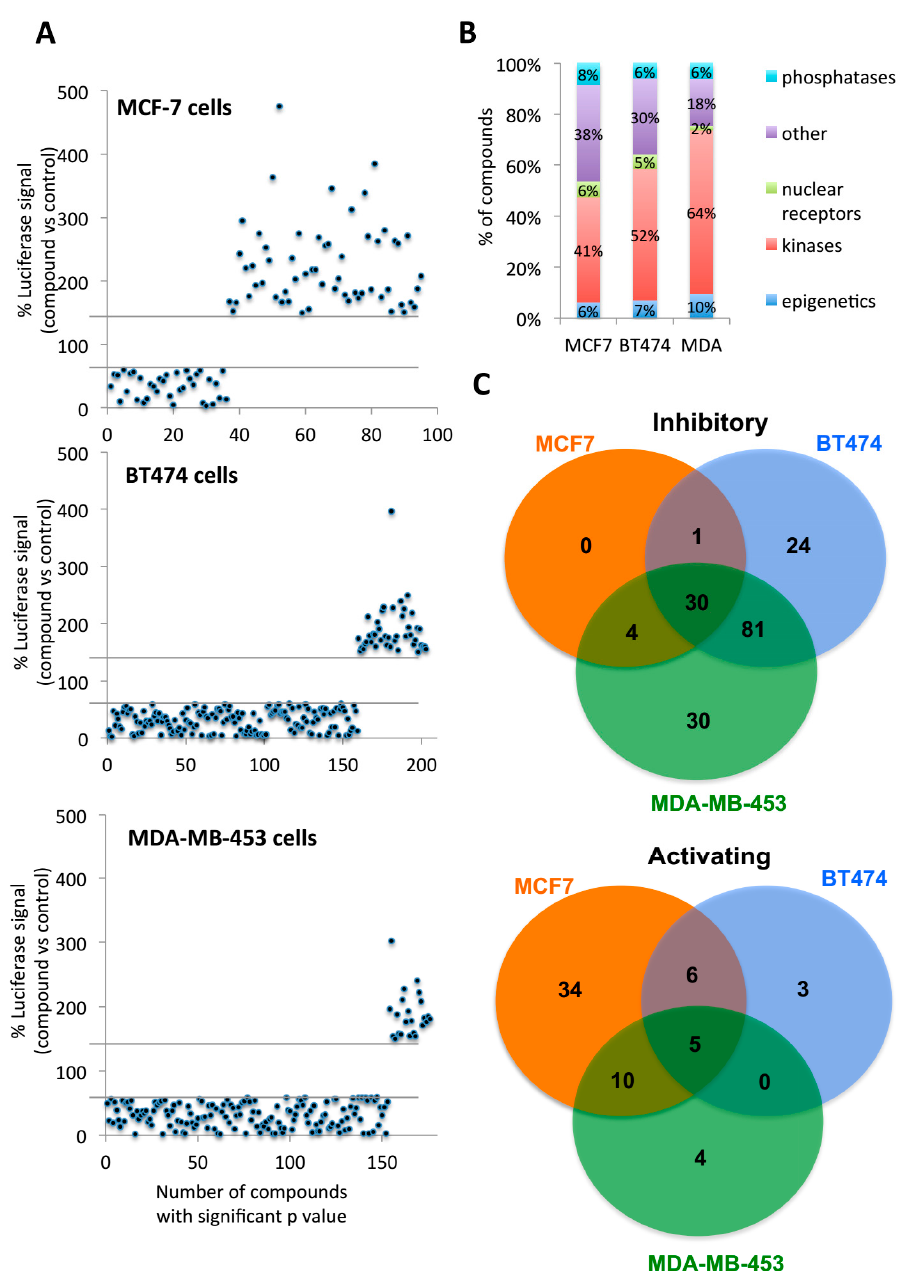
Figure 2. Multiple chemicals were identified positive in the chemical screening. ( A ) Three plots indicating the number of significant compounds ( T test; two tails; p < 0.05) that affect the luciferase expression in each of the breast cancer cell lines investigated (MCF-7, BT474, and MDA-MB-453). Each plot illustrates the % of luciferase expression of cells treated with compounds and normalized to control treated cells (treatment/control). We have represented the compounds with a significant increase (more than 150%) or decrease (less than 40%) luciferase expression compared to control. ( B ) Fraction (expressed in %) of significant compounds targeting different group of proteins: phosphatases, nuclear receptors, kinases, epigenetics and other groups. The plot represents the % of group of compounds with a significant p value for each cell line investigated. ( C ) Venn-diagram showing the overlap of positive chemicals between MCF-7, BT474, and MDA-MB-453 cells. Inhibitory ( upper ) and activating ( lower ) are showed independently. The number of positive chemicals in MCF-7, BT474, and MDA-MB-453 were showed in different columns with activating chemicals in red and inhibitory chemicals in blue.